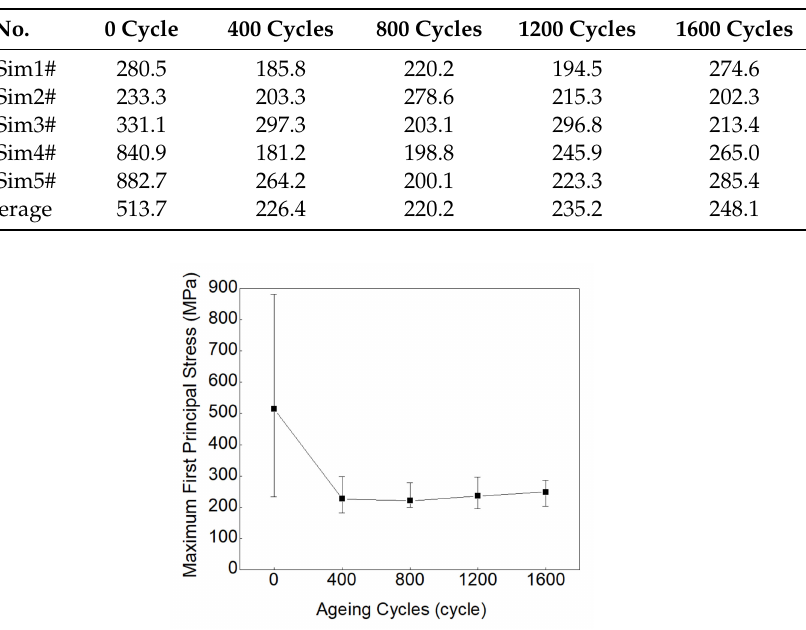
Figure 5. The first principal stress distribution of solder joints. Table 6. The first principal stress of solder joints.